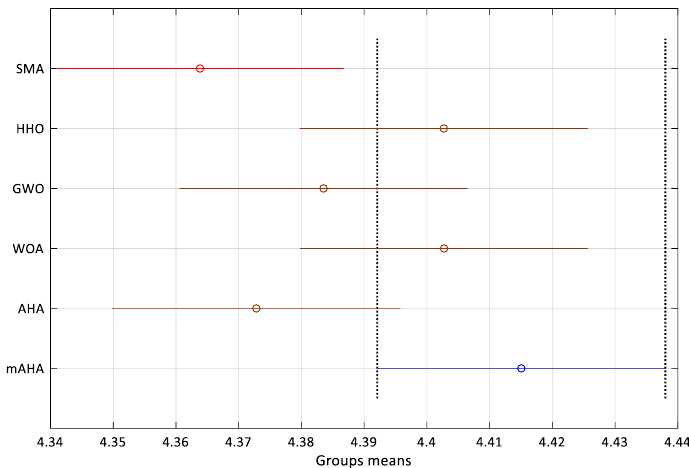
Figure 11. Tukey test for the second shadow scenario.